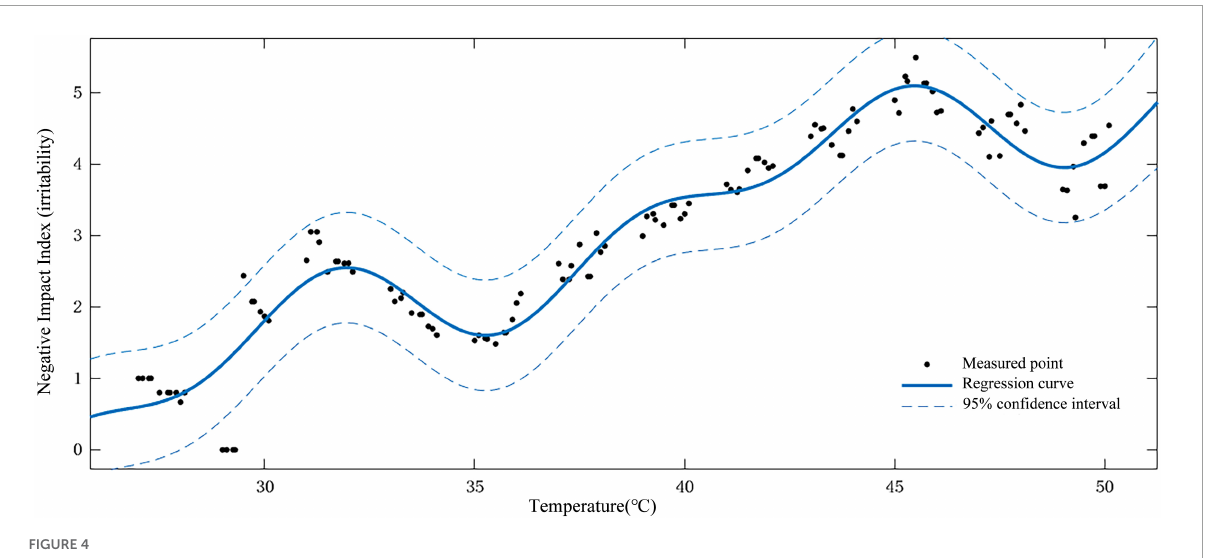
FIGURE4 Relational model between instantaneous temperature and